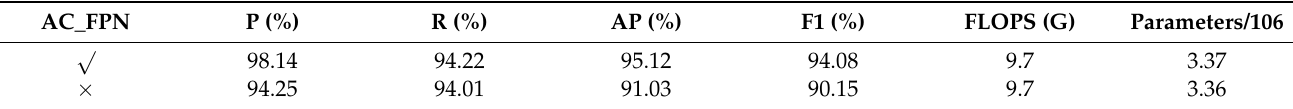
Table 9. Ablation study of YOLOv5-AC with and without AC_FPN.